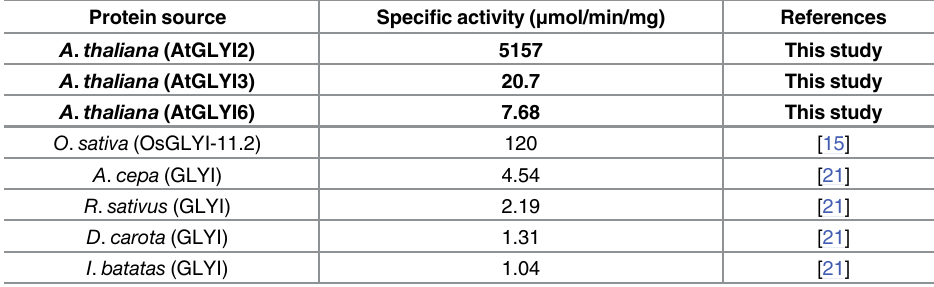
Table 2. Comparison of the specific activity of the GLYI proteins of Arabidopsis with GLYI proteins from other plant species. Protein